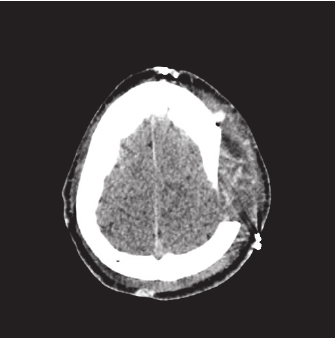
Figure 10. Parietal bone